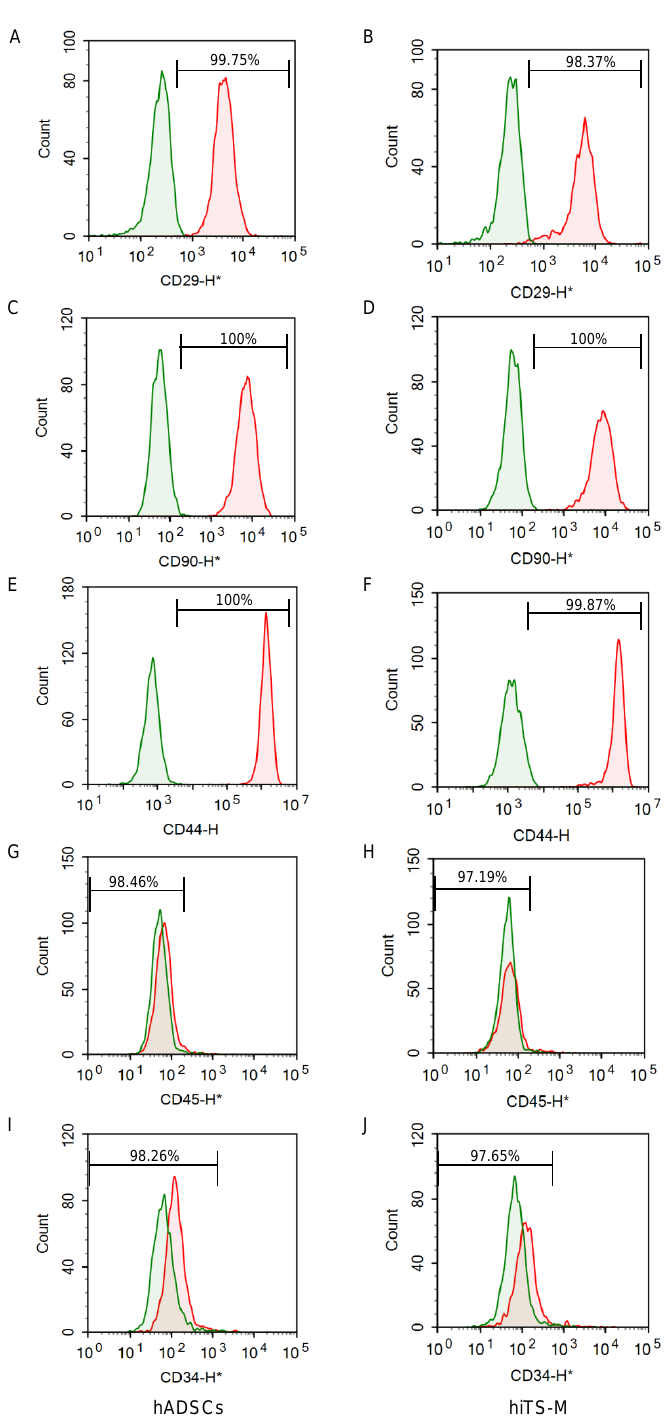
Figure 2. Flow cytometric analysis. hiTS-M cells (passage 14 + 7) and hADSCs (passage 7) were analyzed: ( A ) hADSCs, CD29; ( B ) hiTS-M cells, CD29; ( C ) hADSCs, CD90; ( D ) hiTS-M cells, CD90; ( E ) hADSCs, CD44; ( F ) hiTS-M cells, CD44; ( G ) hADSCs, CD45; ( H ) hiTS-M cells, CD45; ( I ) hADSCs, CD34; and ( J ) hiTS-M cells,